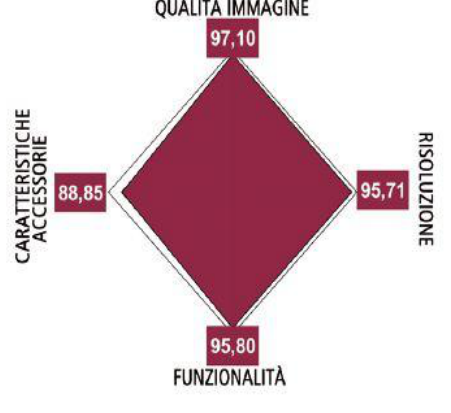
Figure 6. Evaluation test of camera Nikon (Origin: DXO, France)